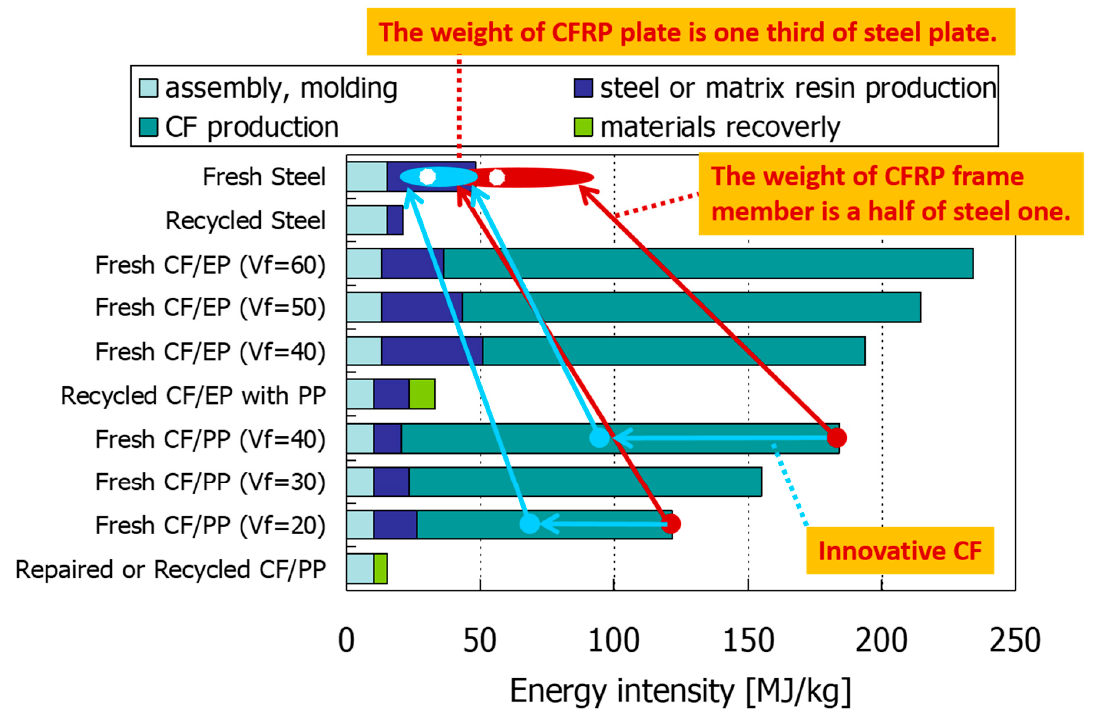
Figure 19. Energy intensities of fresh and recycled steel, CF/epoxy composite, and CF/polypropylene (PP) composite.